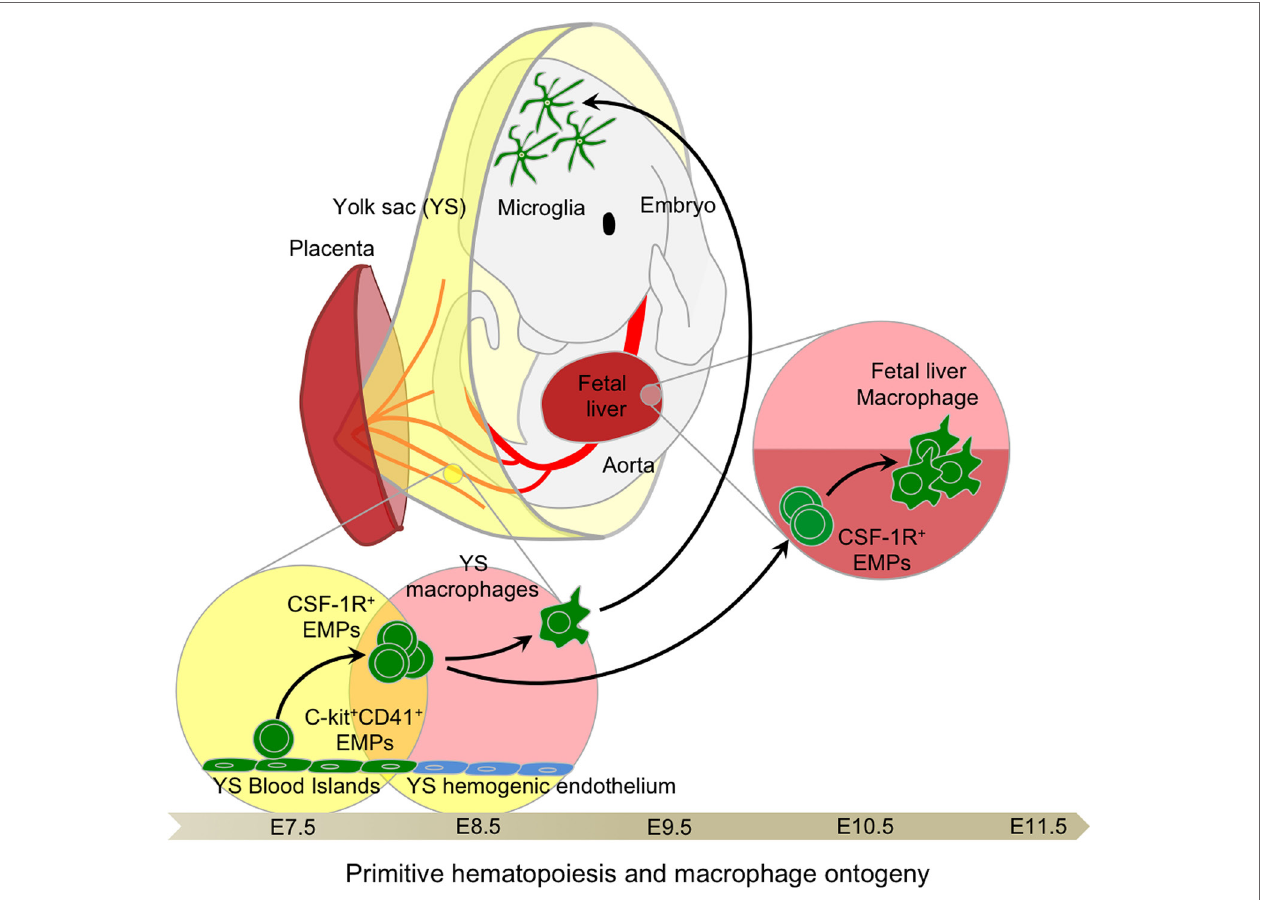
FiGURe 2 | Primitive hematopoiesis and yolk sac macrophage ontogeny . Early EMPs emerge in the YS around E7.5 before establishment of the blood circulation. They express CD41 and CSF-1R and are independent of the transcription factor C-Myb. Upon establishment of the blood circulation around E8.5, EMPs differentiate into primitive macrophages as well as primitive erythrocytes and granulocytes. Primitive macrophages seed all fetal tissues, in particular the head where they will give rise to future brain microglia that are able to continuously self-renew throughout adulthood. EMPs seeding the fetal liver briefly expand to generate a local macrophage population, likely important for sustaining enucleation of primitive erythrocytes passing through the sinusoid prior to the establishment of definitive hematopoiesis and the generation of fetal monocyte-derived macrophages in the fetal